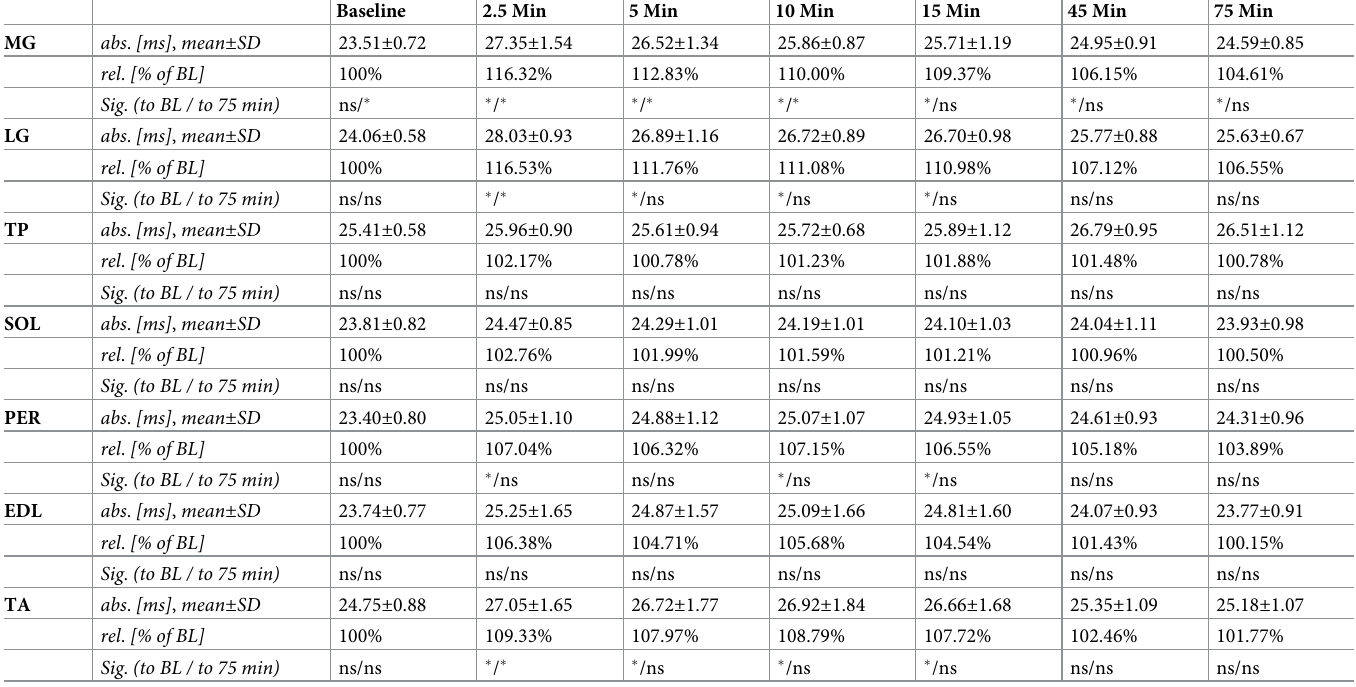
Table 3. Absolute and relative changes of the T2 � relaxation times during prolonged running.